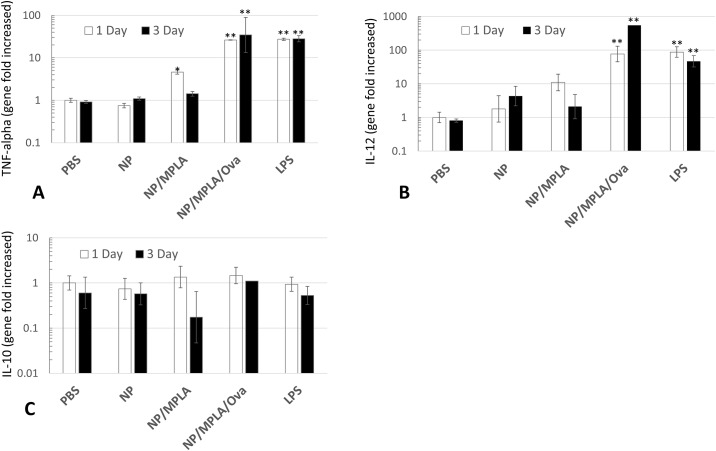
Effects of incubation of PLGA NP preparations on TNF-alpha (A), IL-12p40 (B), and IL-10 (C), gene expression by canine macrophages.Day 7 canine macrophages (1x106/mL) were pretreated with 50 μg/mL of PLGA NP, PLGA NP/MPLA, PLGA NP/OVA/MPLA or LPS (1 μg/mL) for 24 hours or 36 hours. GAPDH was used to normalize the results. * Statistically significant difference when compared to PBS and PLGA NP-treated group (P<0.05). ** Statistically significant when compared with PLGA NP/OVA/ MPLA treated macrophages (P < 0.05). Similar data were obtained in three independent experiments.